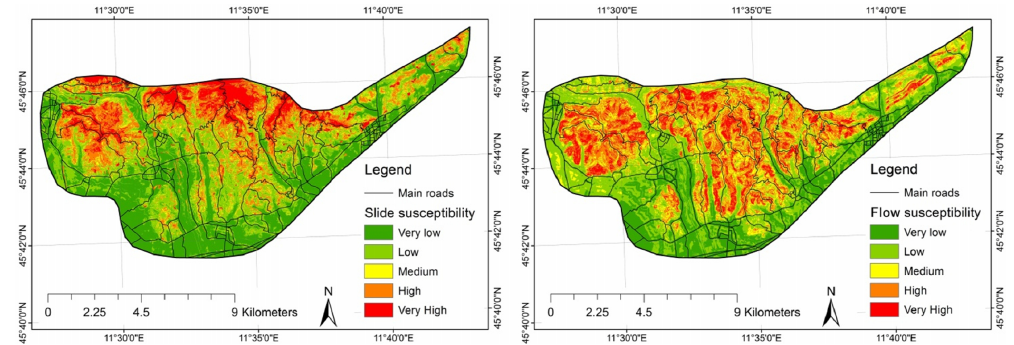
Figure 7. Translational/rotational slide and earth flow susceptibility maps. The classification of susceptibility is based on the results of the validation, interpreting predictive rate curves of Fig.